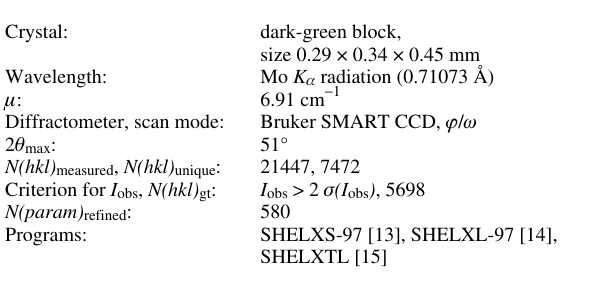
Table 1. Data collection and